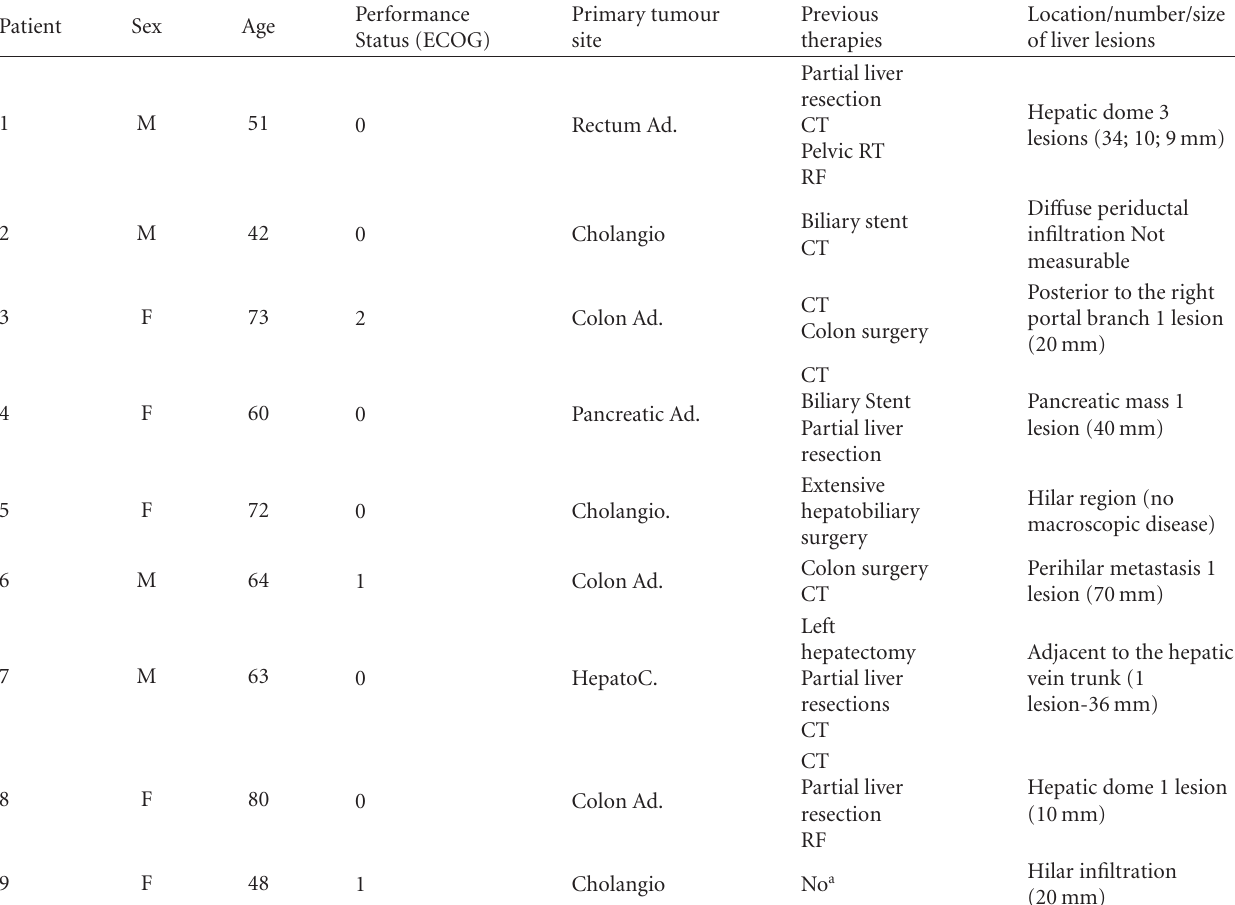
Table 1: Patient and disease